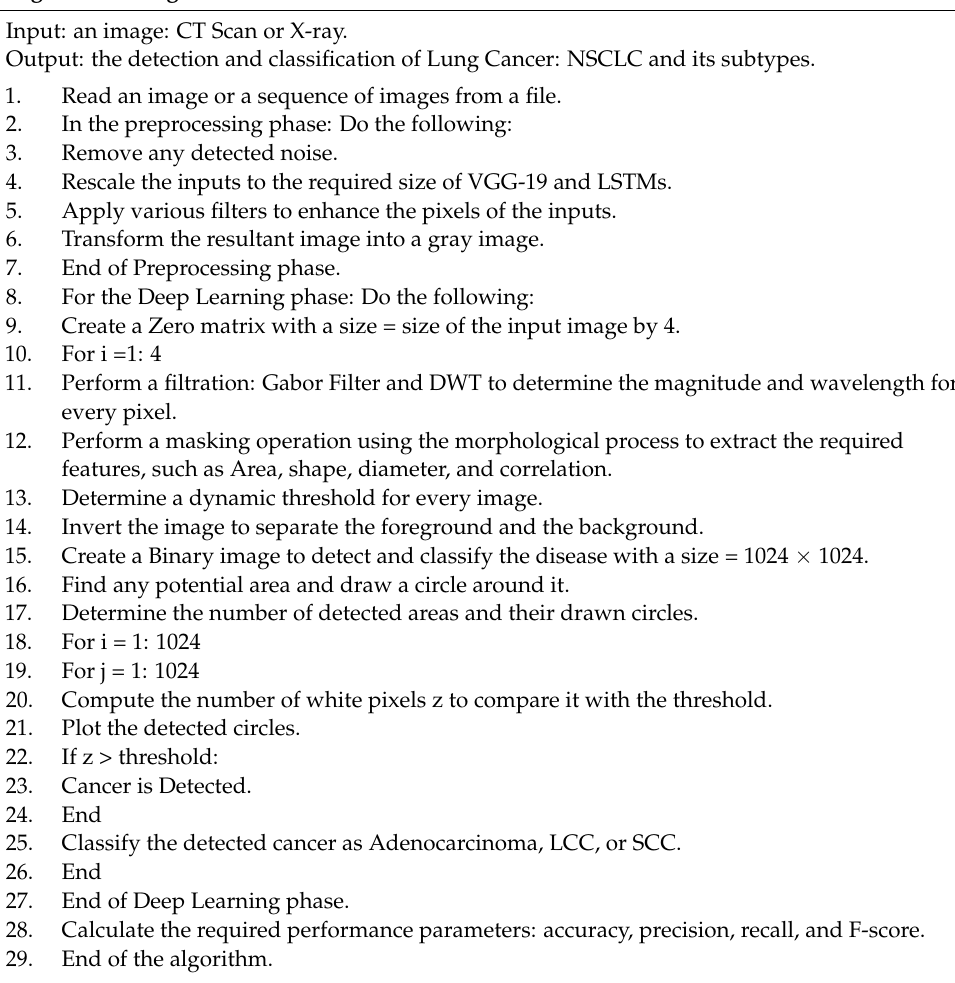
Algorithm: Lung Cancer Detection and